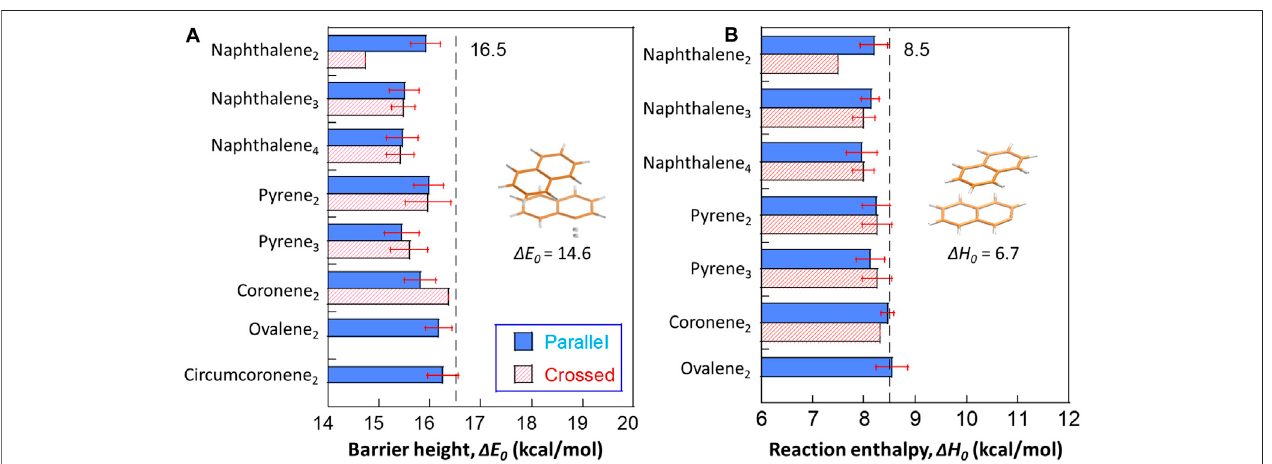
a All energies are in kcal/mol. Only the parallel con fi gurations are considered. The uncertainties refer to one standard deviation in the predictions of energy barriers. b Only the hydrogen radical and the abstracted hydrogen atom are not frozen in the searching of the saddle point. c The hydrogen radical and any neighboring atoms within 3 Å away from the radical are not frozen in the searching of the saddle point. d 32, 30, and 24 transition states are explored for napthalene 4 , pyrene 3 and coronene 2 clusters, respectively. The ± values refer to one standard deviation in the predicted errors.